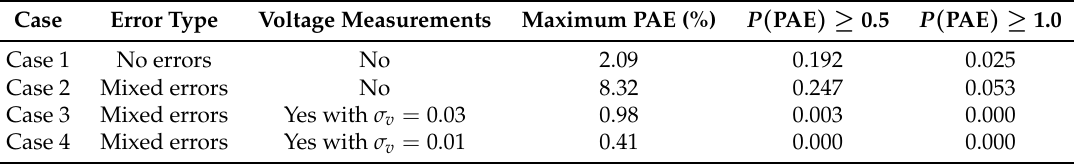
Table 5. Evaluation of the DSSE algorithm with multiple uncertainties using the 2018